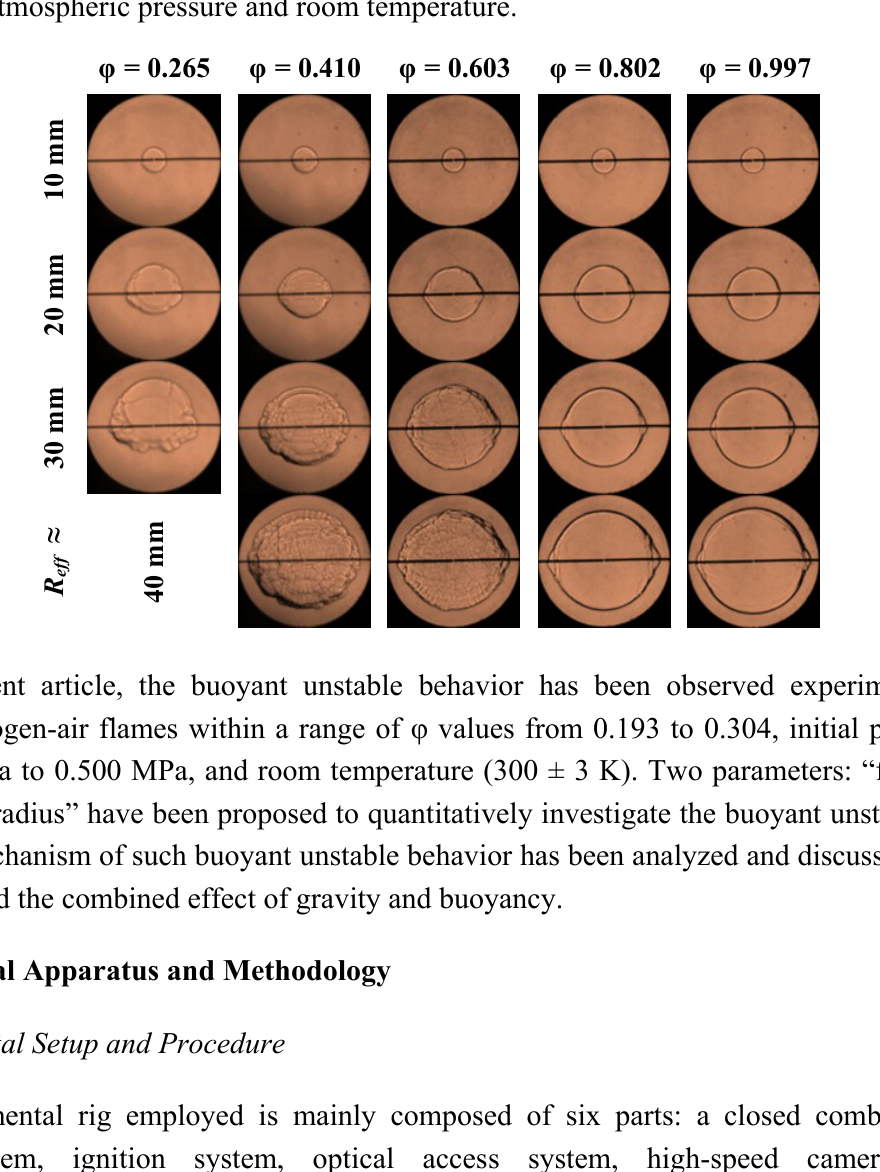
Figure 1. Schlieren images of hydrogen-air premixed flames with different equivalent ratios at atmospheric pressure and room